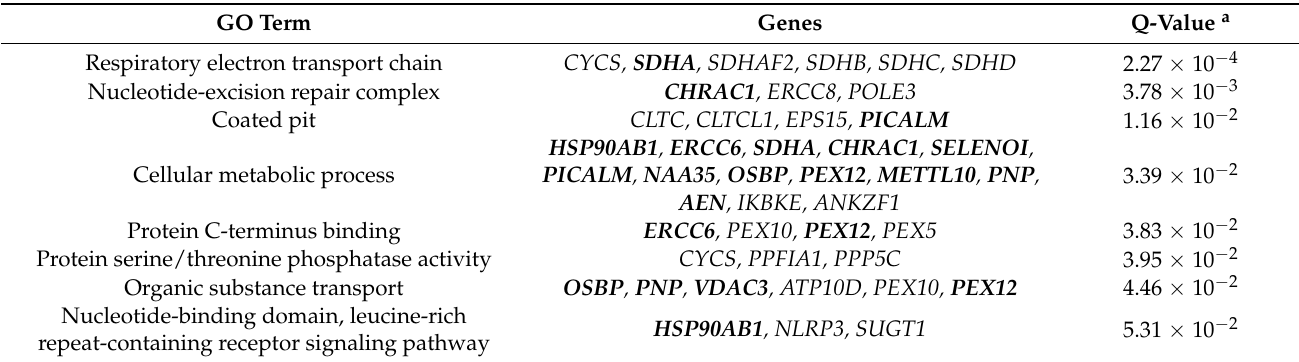
Table 2. The gene ontology (GO) terms enriched in the TDP-43 network constructed in this study. GO